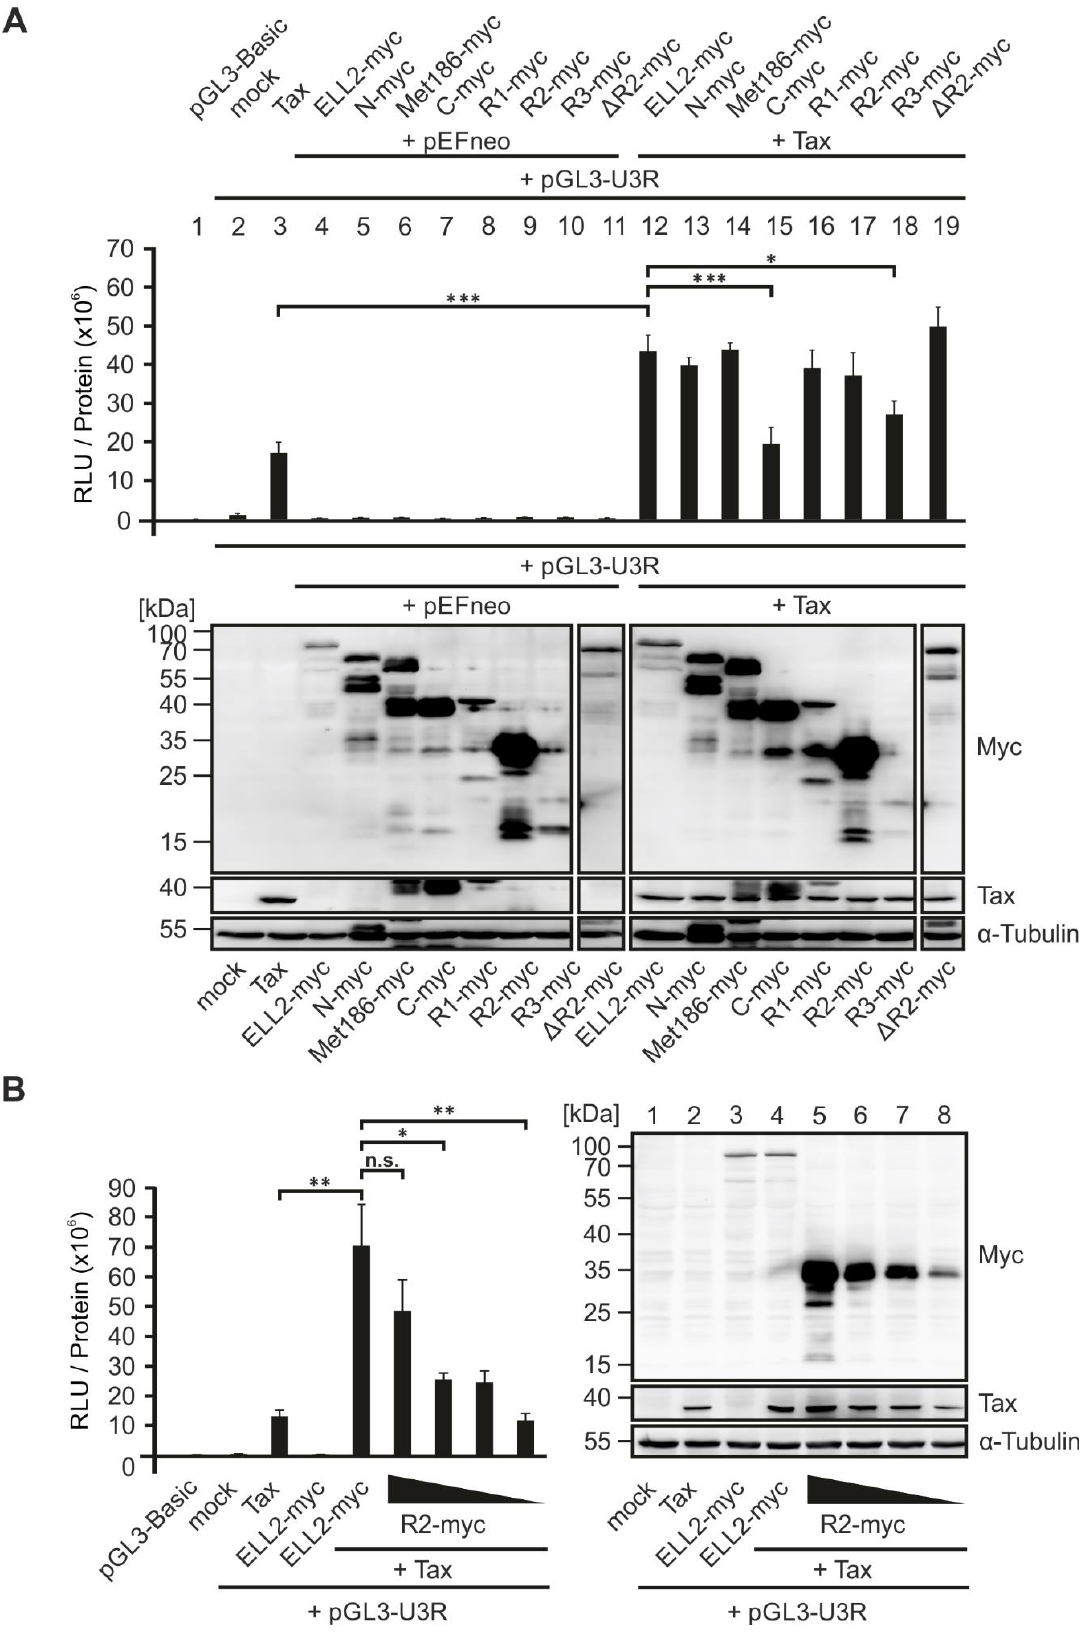
Figure 7. ELL2-R1 is sufficient for enhancing Tax-1-mediated transactivation of the HTLV-1 promoter. ( A ) Luciferase reporter gene assays (upper part) and corresponding Western blots (lower part). 293T cells were transfected with